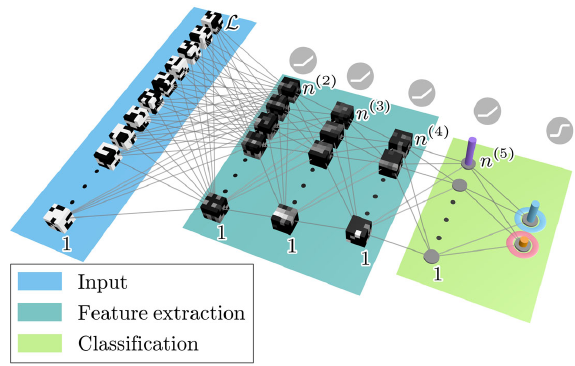
FIG. 1. Architecture of the 3D convolutional neural network used to obtain T N for the 3D Hubbard model. For input, we use the auxiliary field configurations in a four-dimensional grid, three spatial dimensions of size 4 (total of N ¼ 4 3 sites), and one imaginary time dimension of size L ¼ 200 . Numbers of volu- metric feature maps in the hidden-feature extraction layers are n ð 2 Þ ¼ 32 , n ð 3 Þ ¼ 16 , and n ð 4 Þ ¼ 8 . Here, n ð 5 Þ ¼ 8 in the fully connected layer. During training, dropout regularization with a rate of 0.5 was used to mitigate overtraining. To classify the input system as ordered or unordered, each of the eight fully connected neurons is connected to each of the two readout neurons using the softmax function as a neural activation function. The output neuron with the highest probability represents the activated